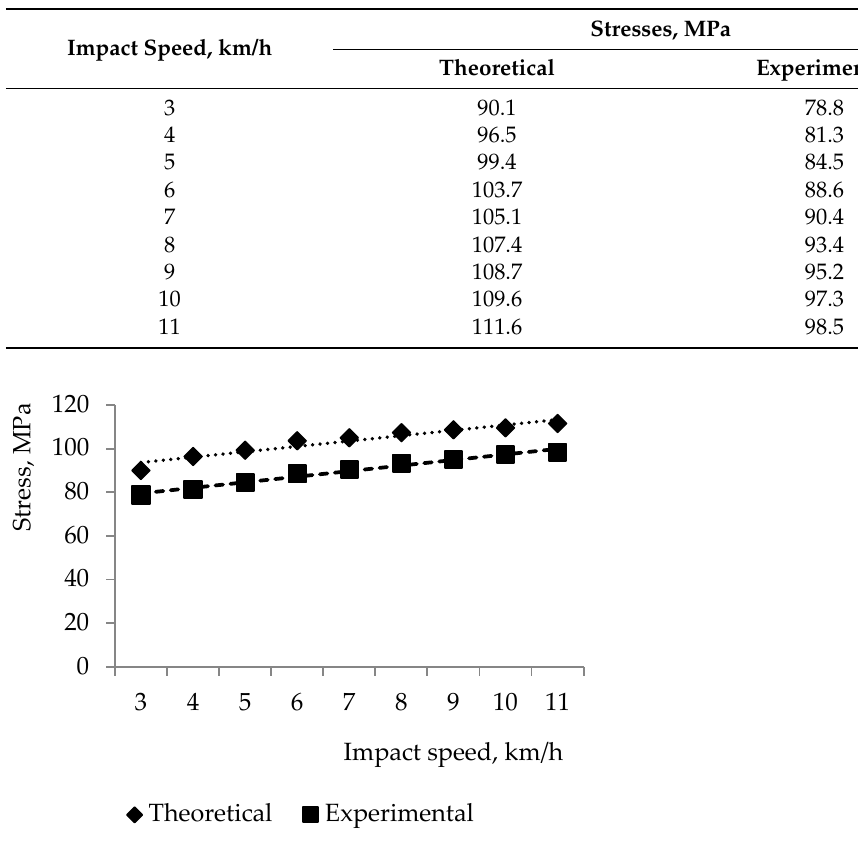
Table 3. The stresses in the flatcar frame during a collision (strain gauge 5).